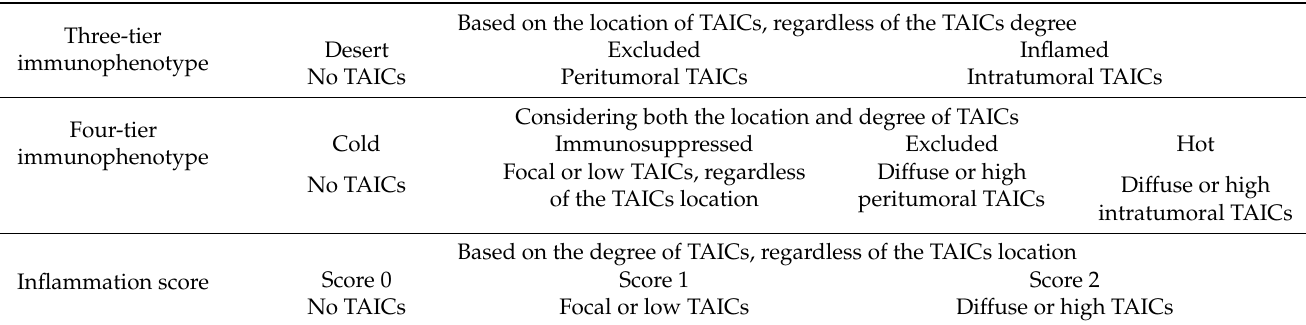
Table 1. Comparison of three evaluation methods of the tumor immune microenvironment.